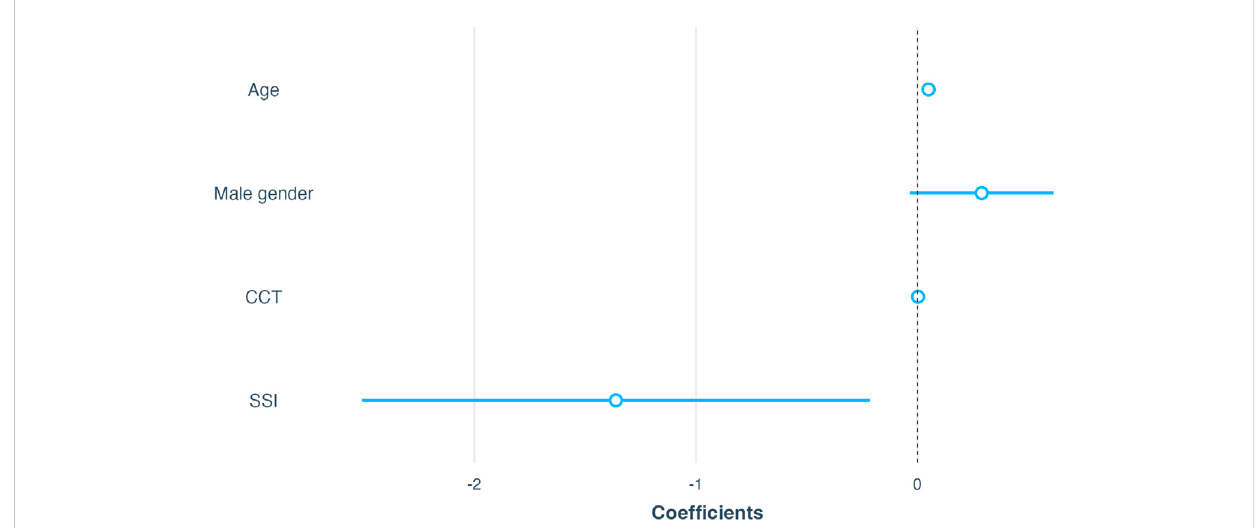
FIGURE 7 Association of SSI with Δ AL among subjects with AL ≥ 26 mm. All coef fi cients were reported using unstandardized coef fi cients, and the 95% con fi dence intervals were used to describe the uncertainties of coef fi cients. Abbreviations: SSI, Stress-strain index; CCT, Central corneal thickness; AL, Axial